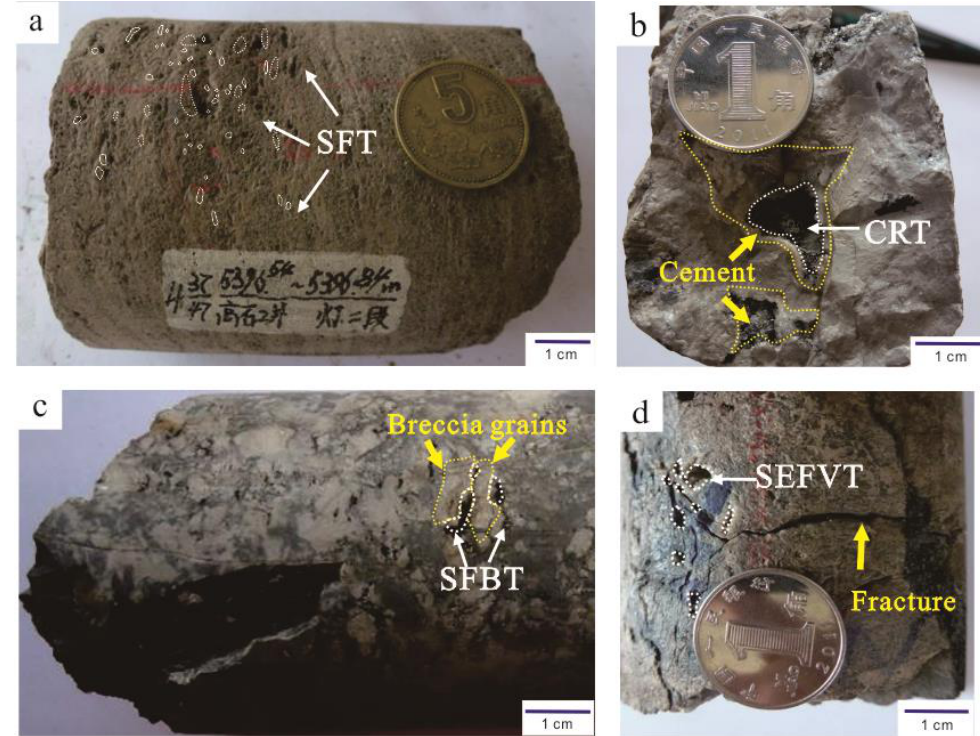
Figure 2. Typical macroscopic characteristics of void space types in cores: ( a ) solution-filling type (SFT) void spaces in a core sample from Well #2 at depth from 5396.54 to 5396.84 m—the white circles show the millimeter-sized pores along the core bedding; ( b ) cement-reducing type (CRT) void spaces in a core sample from Well #1 at depth from 4962.15 to 4962.24 m—the cement-reducing type (CRT) (inside the white circle) is surrounded by the multiple- period dolomite cement (yellow circle); ( c ) solution-filling breccia type (SFBT) void spaces in a core sample from Well #1 at depth from 4978.12 to 4978.23 m—pores are enclosed between the breccia grains; ( d ) solution-enlarging fractures and vugs type (SEFVT) void spaces in a core sample from Well #6 at depth from 5102.12 to 5102.23 m, showing the pores distributing along the fractures.